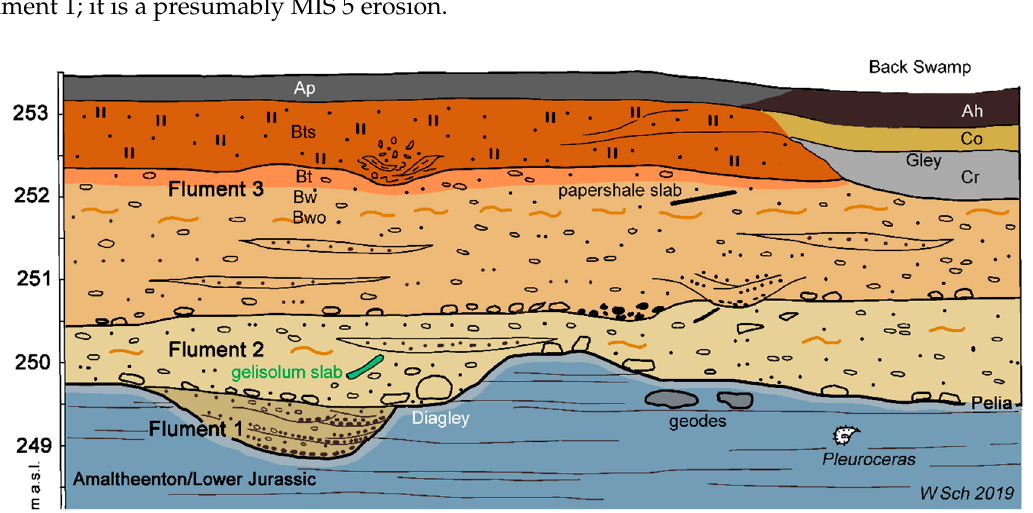
Figure 17. Three stacked fluments in the valley underground below a Last Glacial terrace. Sketch of the construction pit of the sewage Unterzettlitz close to Bad Sta ff elstein / Bavaria (Location in Figure 1). Length about 100 m. Height enlarged about eight times. Flument 1 shows a warm-climate L-flument (presumably MIS 5). Flument 2 presents the Reundorf Flument (70–c. 30–20 ka). Flument 3